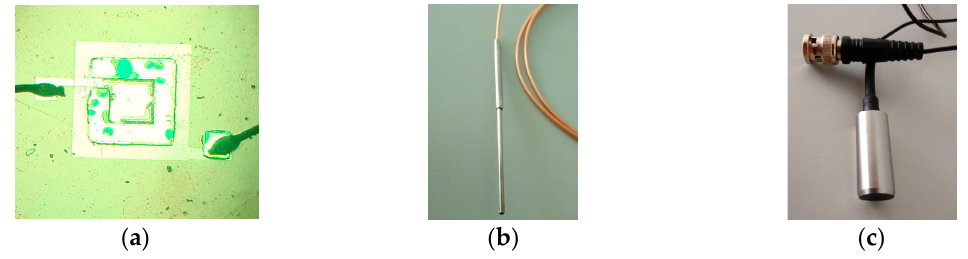
Figure 11. Optical images of ( a ) pMUT with partially-etched ZnO film and the calibrated ( b ) hydrophone; ( c ) transmit transducer used in sensitivity test.